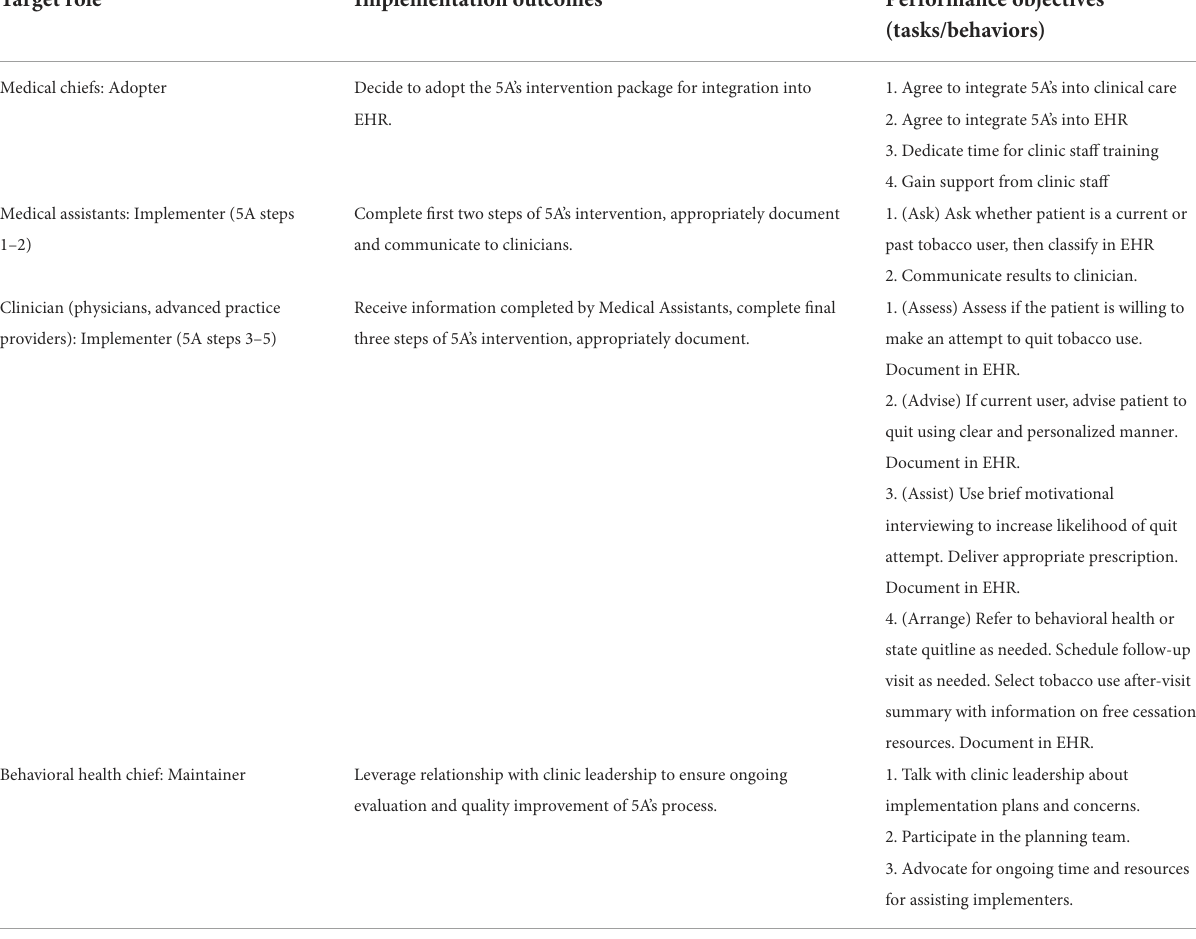
TABLE 2 Performance objectives and implementation